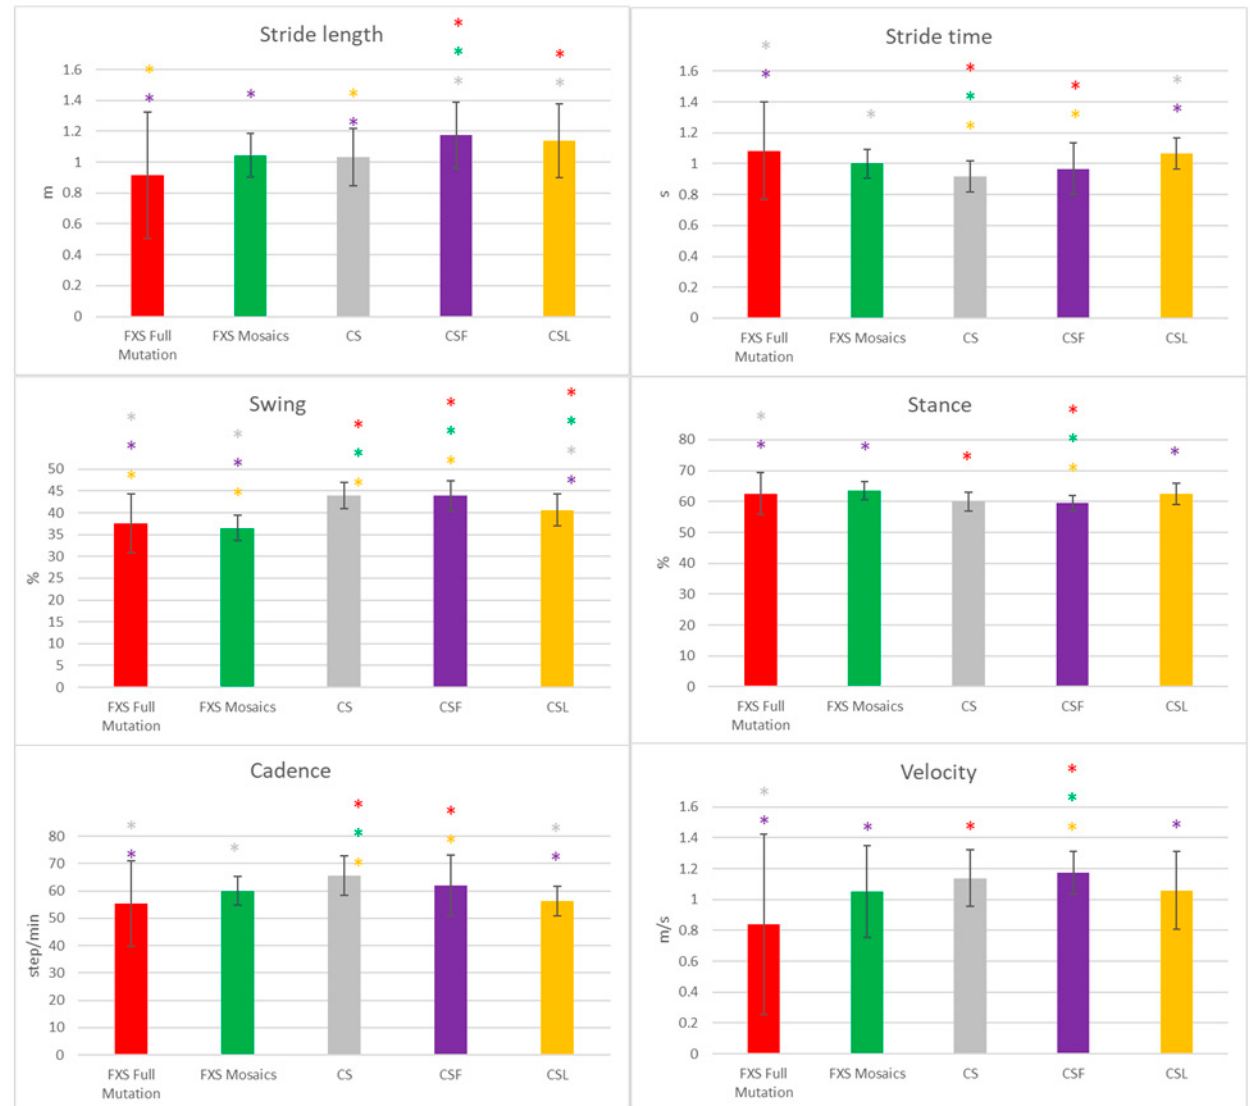
Figure 4. Spatiotemporal parameters of gait in FXS Full Mutation (red), FXS Mosaics (green), CS (grey), CSF (purple), CSL (yellow). Median and interquartile range (IQR) with asterisk (*) when statistically significant differences are observed ( p -value of the Wilcoxon rank-sum test < 0.05): red with respect to FXS Full Mutation, green with respect to FXS Mosaics, grey with respect to CS, purple with respect to CSF and yellow with respect to CSL. Colours refer to the online version of the figure.